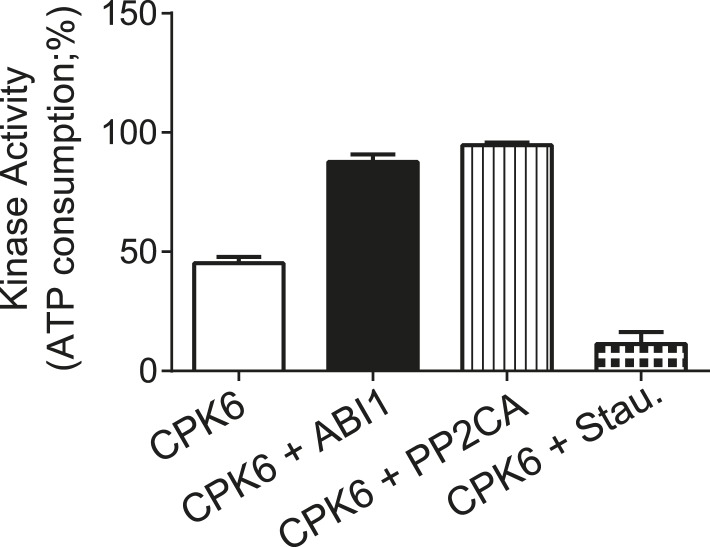
CPK6 kinase activity is not inhibited in the presence of ABI1 or PP2CA.In vitro protein kinase assays measuring the kinase activity via ATP consumption show that staurosporine (Stau.) but not ABI1 or PP2CA inhibited CPK6 kinase activity. The increased ATP-consumption signal in the presence of ABI1 and PP2CA can be explained by higher ATP consumption triggered by kinase auto-phosphorylation of residues removed by the PP2C protein phosphatases. Data shown represent the mean of three experiments ± SD.